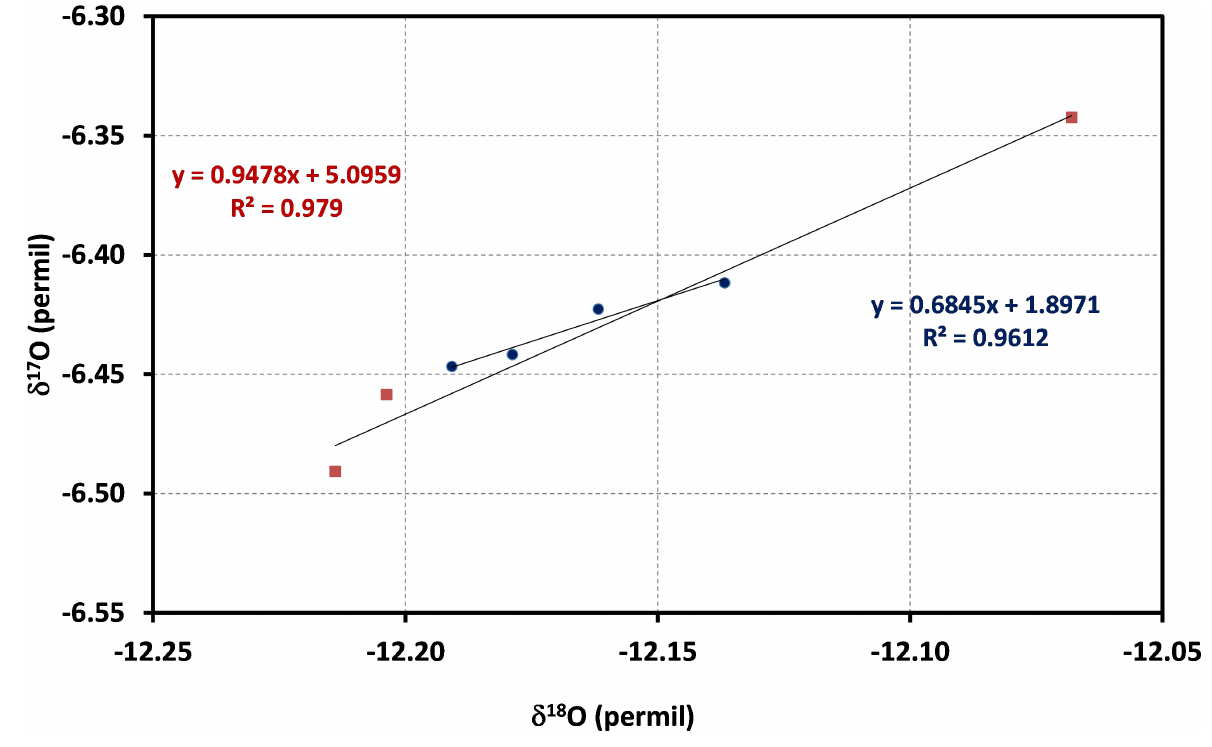
the fact that we do not understand where the limitation is coming